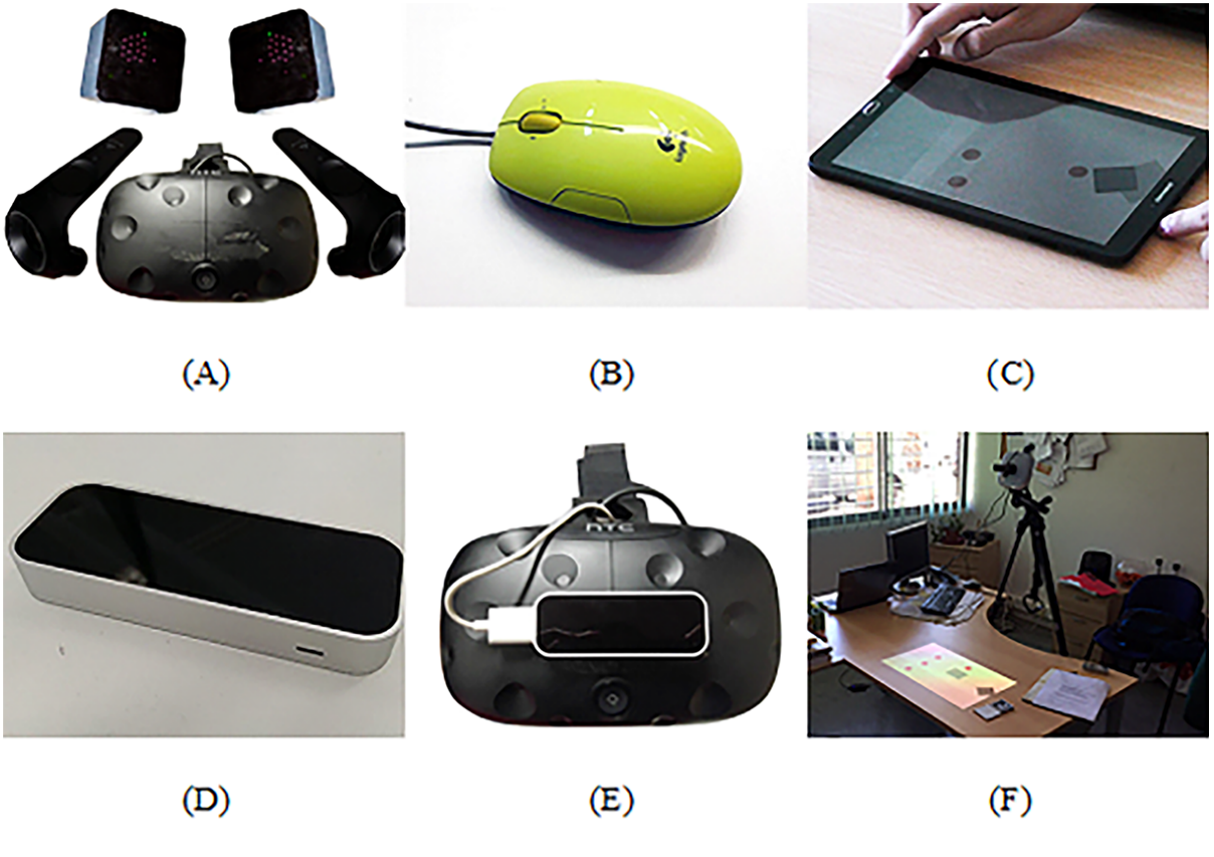
Figure 1. Technologies used during the experimental trial. (A) HMD with Controllers. (B) Mouse. (C) Tablet. (D) Leap Motion. (E) HMD with Leap Motion. (F) Augmented